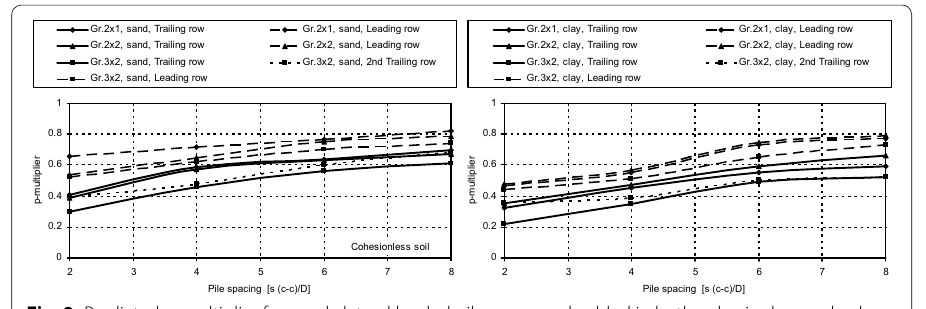
Fig. 9 Predicted p‑multiplier for purely lateral loaded pile group embedded in both cohesionless and cohe‑ sive soil, at 3 m depth, (groups 2